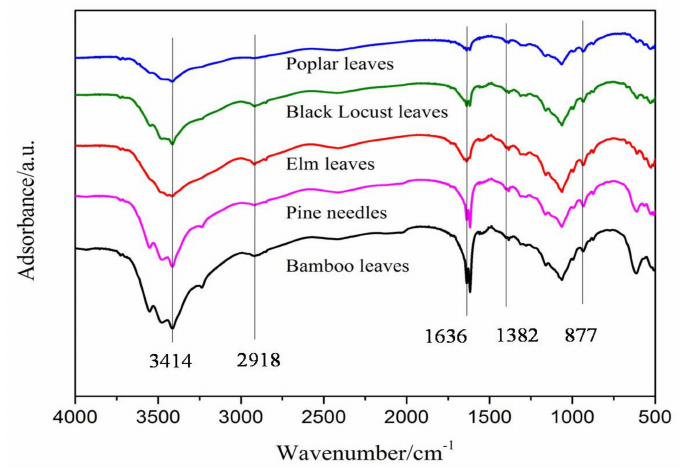
Figure 4. FTIR spectra of CNPs prepared from (a) pine needles, (b) black locust leaves, (c) poplar leaves, (d) elm leaves, and (e) bamboo